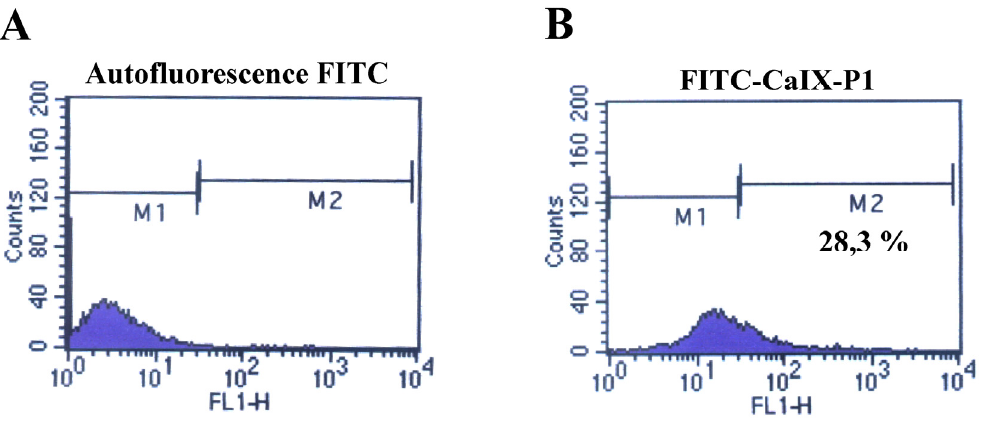
Figure 7. Fluorescence-activated cell sorting analysis. ( A ) Autofluorescence of HCT116 cells at 530nm (FL1). ( B ) Fluorescence of HCT116 cells after incubation with FITC-CaIX-P1. ( C ) Autofluorescence of HCT116 cells at 590nm (FL2). ( D ) Fluorescence of HCT116 cells after incubation with rhodamine-labeled